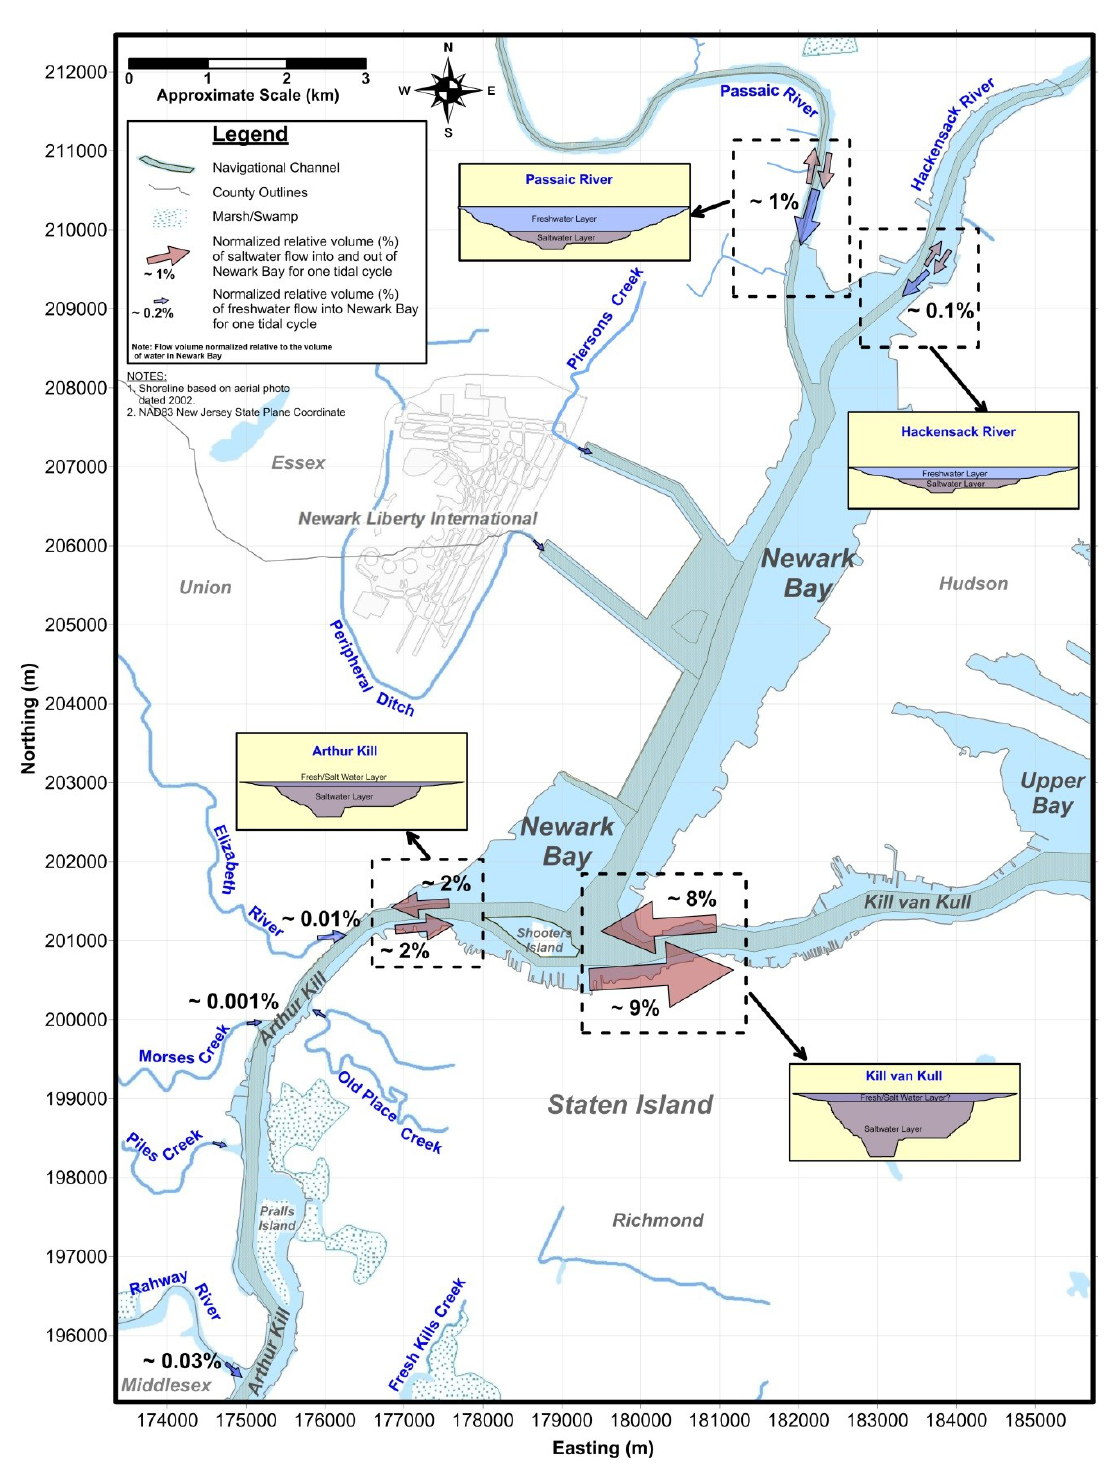
Figure 3. Schematic of the two-layer circulation pattern in the